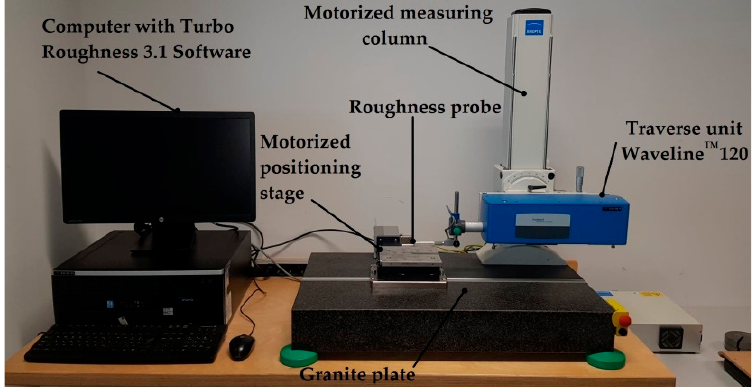
Figure 4. Scheme of experimental stand.